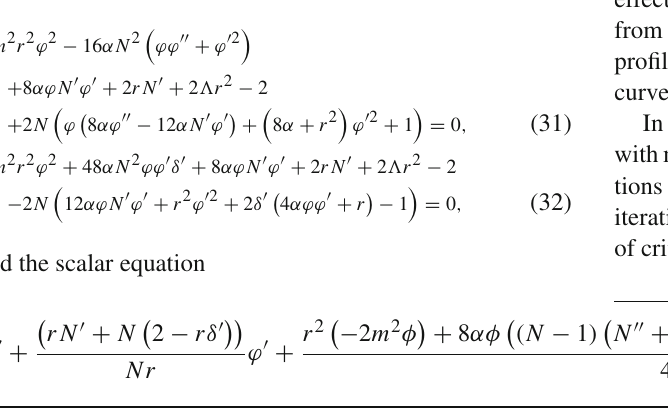
fixed (cid:2) = 0 . 1, which shows that for large m , the ratio α/ M 2 could increase for the bifurcation. Again the green dashed lines are the unstable/stable border from the analysis of QNM frequency with overtone n = 2, which is consistent with the bifurcation points as expected. A typical profile of such scalar cloud is shown in right